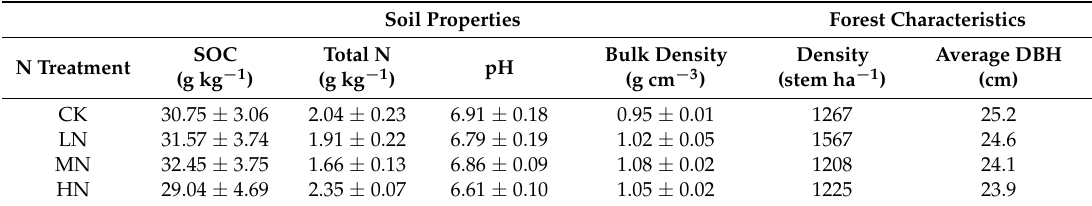
Table 1. Site characteristics of the treatment plots before nitrogen (N) addition in the Pinus tabulaeformis forest. CK, LN, MN and HN denote control, low N, medium N and high N treatment, respectively. DBH is the tree diameter at breast height. Data are mean ±